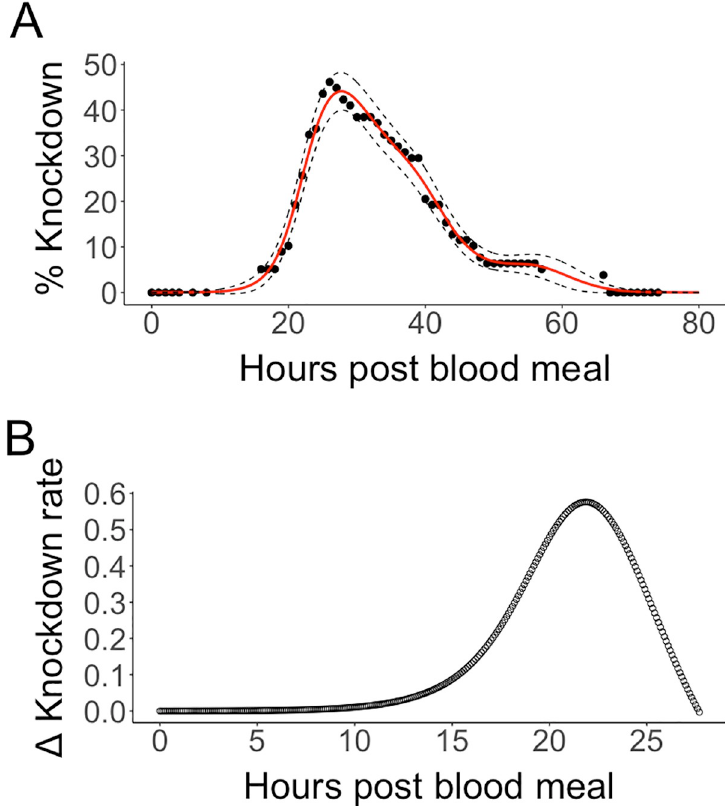
Fig 3. Generalized Additive Model of knockdown/recovery behaviour. Results of a binomial GAM model fitted to VgA1 > AaHIT off-tet cage knockdown data with non-recovered (dead) females removed prior to analysis (panel A). Raw data is represented by black dots with the red solid line showing the back-transformed output from the binomial GAM and black dashed lines showing the CI of the model. This model predicted the peak knockdown point at 27.7hrs pbm with 44.1% ± 2.11 of the cage paralysed. Output from the fitted GAM was used to assess the rate of change in knockdown phenotype over time (panel B). The period from 0–27.7 hrs pbm was divided into bins of 6mins. During each 6min bin the number of females showing the knockdown phenotype (as predicted by the GAM) was compared to that of the previous bin in order to calculate the rate of change during that time period. The X axis is limited to 27.7hrs as this was the maximum knockdown time predicted by the GAM. The bin where females were knocking down most rapidly was at 21.9hrs pbm during which time an estimated 0.576% of the cage began experiencing the knockdown